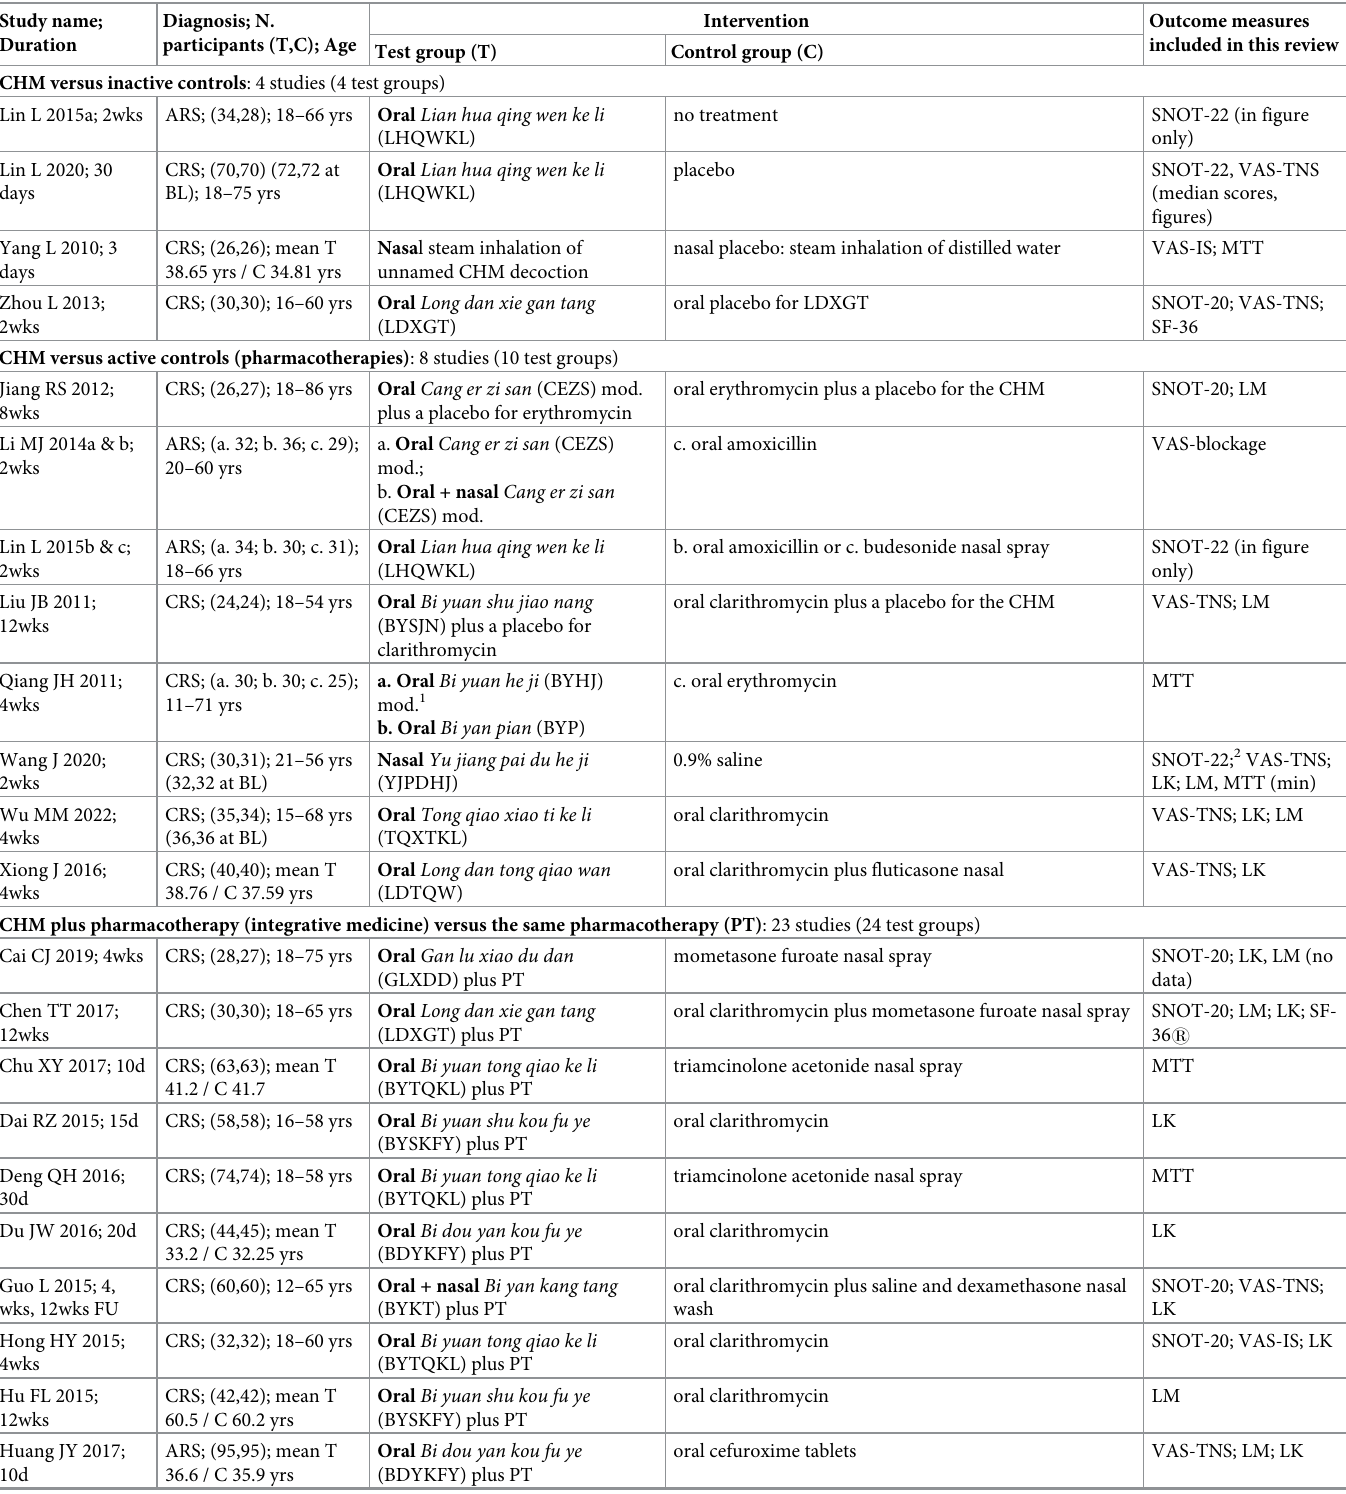
Table 1. Characteristics of included studies of Chinese herbal medicines for rhinosinusitis by